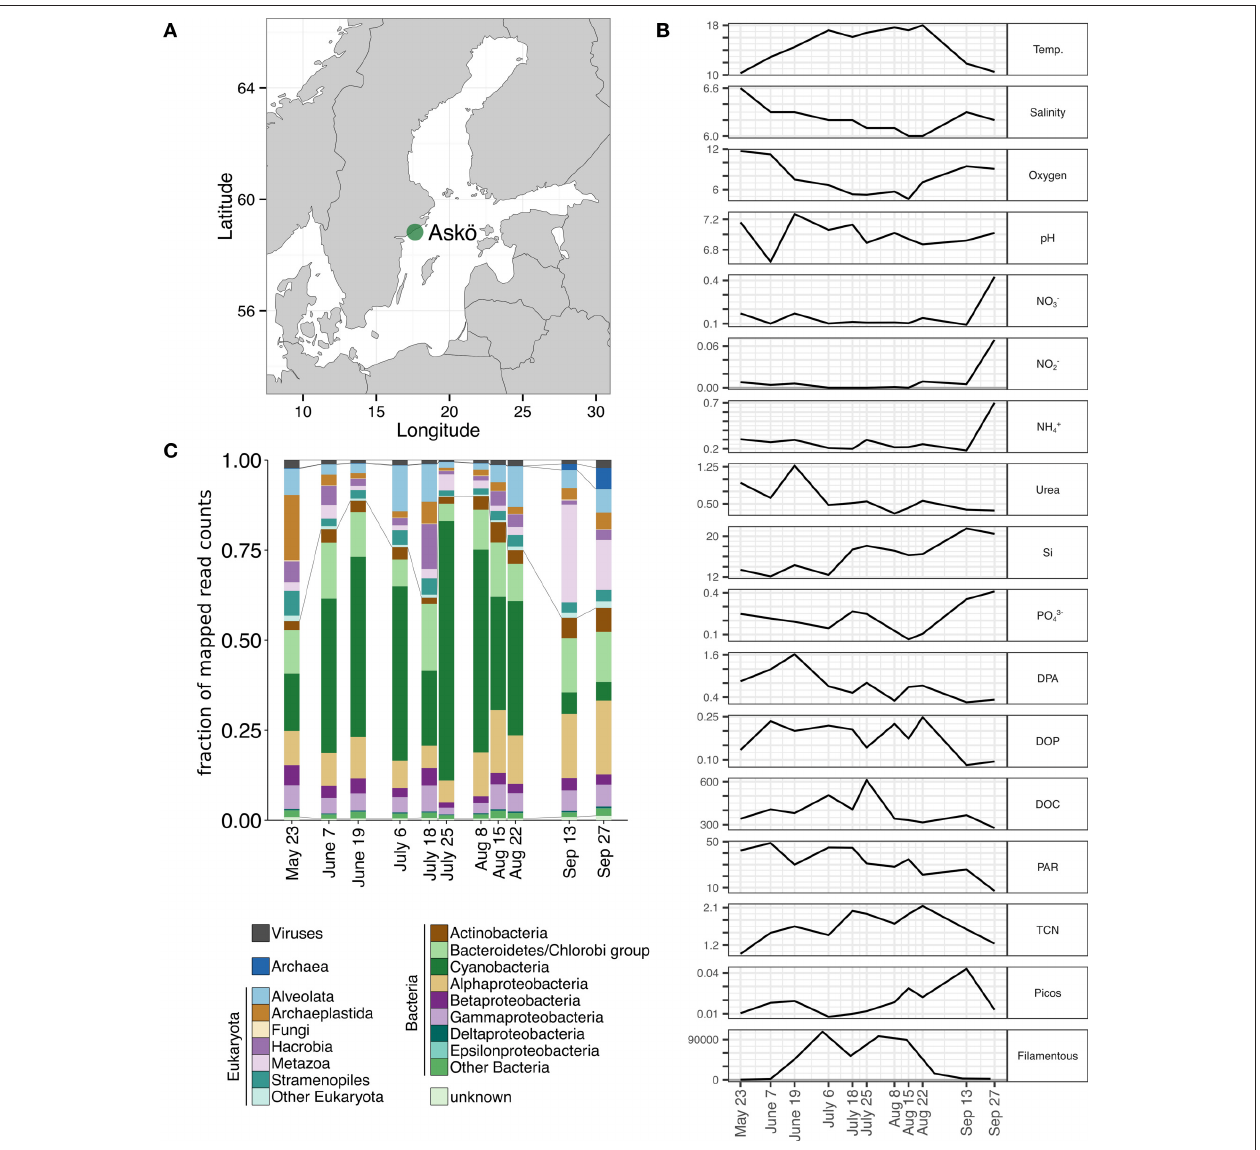
FIGURE 1 | (A) Location of the sampling site off the island of Askö in the Stockholm archipelago in the coastal waters. Samples were taken from the surface in 2012 from May 23 throughout Sep 27. (B) Environmental parameters describing the sampling site. Temp., water temperature ( ◦ C); Salinity (PSU); Oxygen (mg/L); pH; NO − 3 , NO − 2 , NH + 4 , urea, Si, PO 3 − 4 ( µ mol/L); DPA, dissolved primary amines ( µ mol/L); DOP, dissolved organic phosphorus ( µ mol/L); DOC, dissolved organic